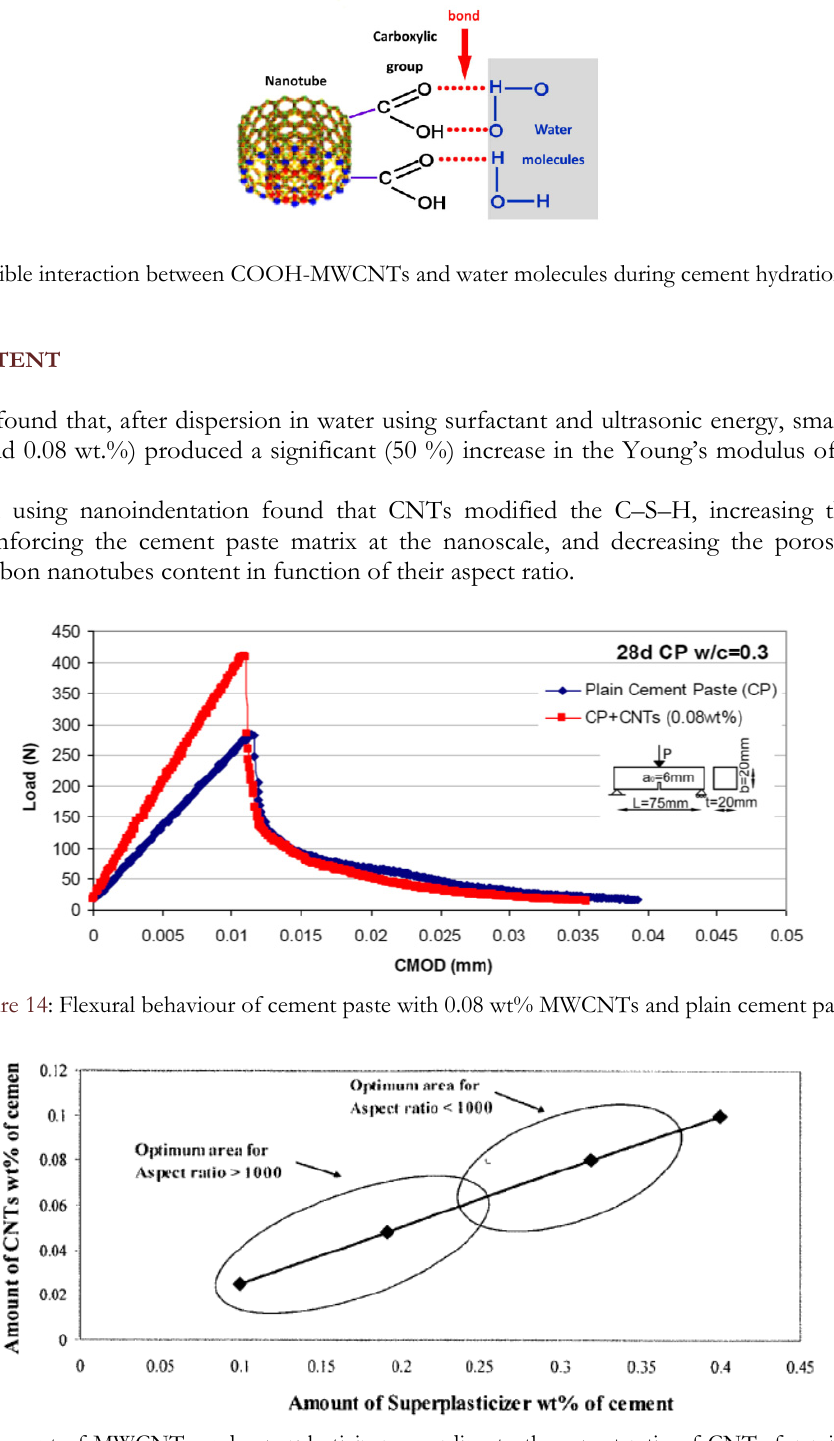
Figure 15: Optimum amount of MWCNTs and superplasticizer according to the aspect ratio of CNTs for reinforcement in cement based materials